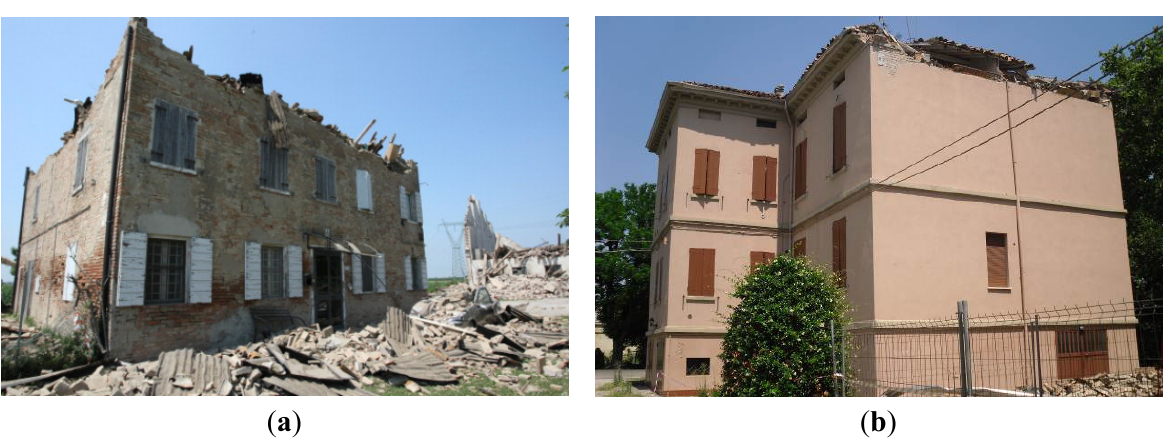
Figure 16. Out-of-plane collapse of peripheral load-bearing masonry walls at the level of thrusting pitched roofs: ( a ) Building in Cavezzo; ( b ) Building in